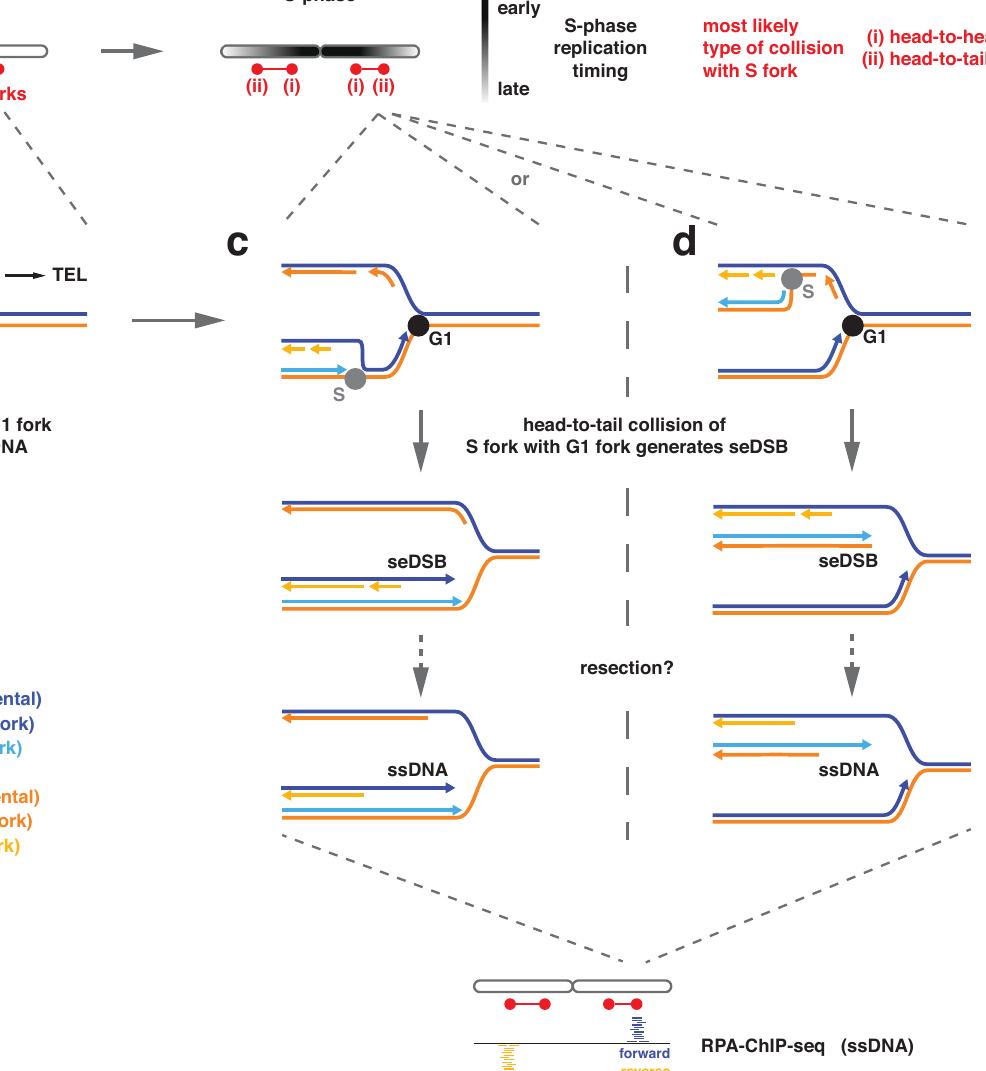
Fig.7|Single-endeddouble-strandbreaksresult fromhead-to-tailcollisionsof S forkswithunterminatedG1forks. a S-phase replication forks are most likely to collide with G1 replication forks in a head-to-tail-orientation. Several factors determine where these collisions occur. First, G1 replication will usually initiate at early fi ring origins thatare preferentially locatedclose to chromosome centers. G1 replicationforks going inward will often be terminated byG1 orS replicationforks that also initiate from early fi ring origins. In contrast, G1 replication forks going outward are less likely to be terminated by a G1 or S-phase replication fork ema- nating from a late- fi ring origin reaches and therefore will be more frequently subject of head-to-tail collisions. b For simpli fi cation, a single replication fork moving to the right telomere is shown. A replication fork moving to the left